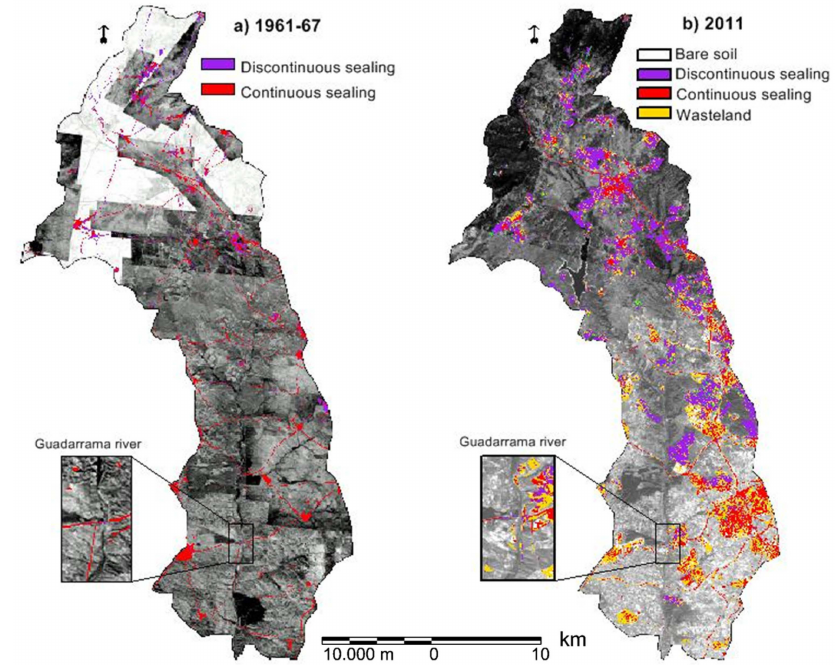
Figure 3. ( a ) Soils sealed in 1961–1967; ( b ) Soils sealed in